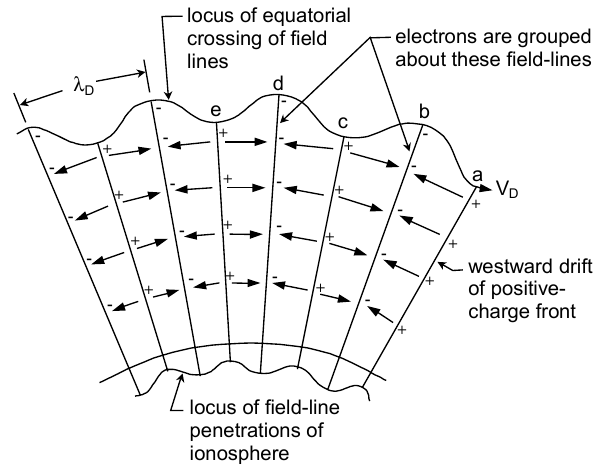
Fig. 7. Illustration of drift-wave resonance of magnetic field lines during azimuthal drift of proton front; adopted from Cladis (1971).